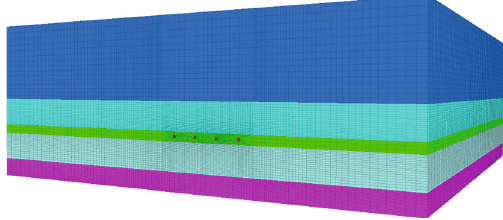
Figure 7: Numerical simulation model.